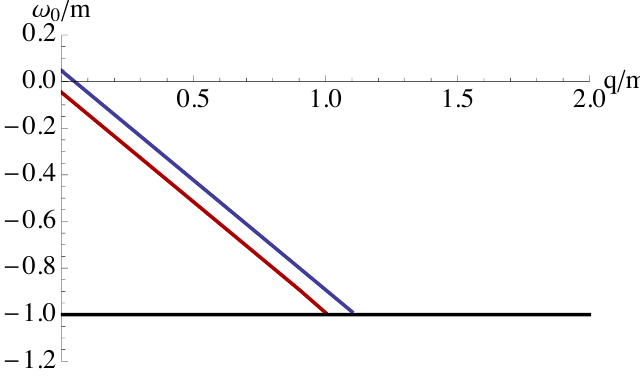
Figure 2 . Ground state frequencies obtained by numerical solution of eq. (2.20). Normalized to m , the frequencies depend only on the combinations q=m , Q=Q max , and mL . We take a point where mL = 100 and Q=Q max (cid:25) 1 = 4, scanning over q=m in 5 d Planck units. The upper solid line (blue) shows ! 0 , the ground state frequency (energy) in the charge (cid:0) q sector. The lower solid line (red) shows the ground state frequency (-energy) in the charge + q sector. The dashed p line denotes the charge + q continuum. For q = 0, ! 0 (cid:24) T (cid:28) m . For small positive q , ! 0 crosses zero. At some q=m (cid:24) O (1), ! 0 crosses into the positive-charge continuum. At this point the energy of an oppositely-charged pair vanishes, and the system becomes unstable against spontaneous pair